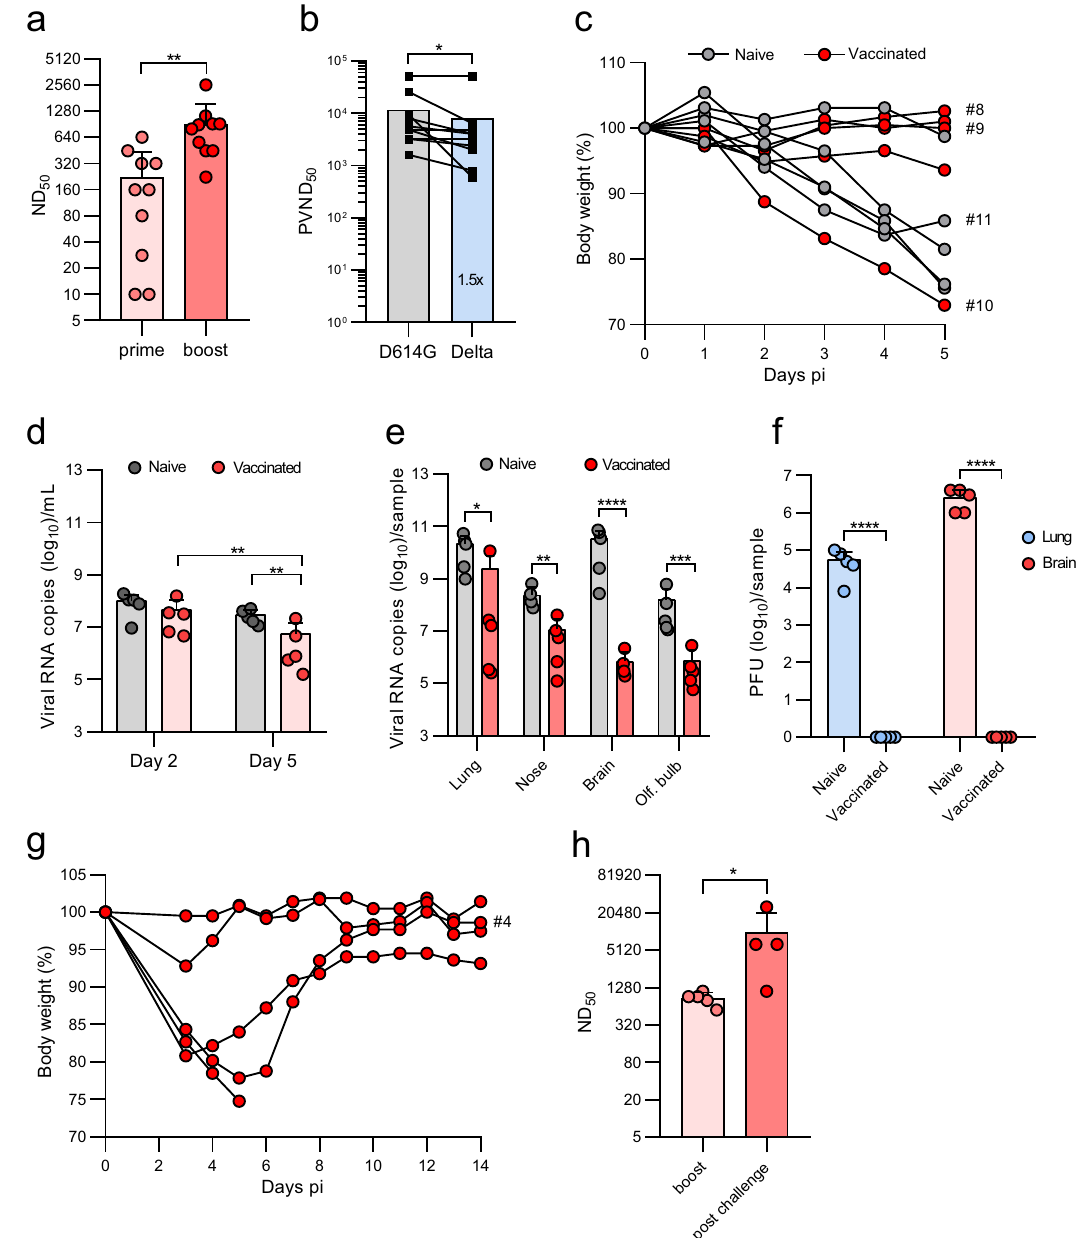
Fig. 7 The VSV* Δ G-S Δ 21 vaccine partially protects K18-hACE2 mice from SARS-CoV-2 Delta infection. K18-hACE2 mice ( n = 10) were immunized (i.m.) twice with 10 6 ffu of VSV* Δ G-S Δ 21. a Determination of VSV* Δ G-S Δ 21 -neutralizing antibodies in serum collected 3 weeks after the fi rst (prime) and 3 weeks after the second immunization (boost). b Determination of the pseudotype virus neutralization dose 50 (PVND 50 ) using the VSV* Δ G(FLuc) reporter virus pseudotyped with the S D614G or S Delta protein. c – h Four weeks after the second immunization, animals were infected with 8×10 4 pfu of SARS-CoV-2 Delta VOC via the nasal route. A group of naïve K18-hACE2 mice ( n = 5) served as control. c Relative body weight of mice in the course of infection up to day 5 pi. Some Individual curves were labeled with an ID number to identify the animals in the histological analysis (Supplementary Fig. 4A). d , e Quanti fi cation of SARS-CoV-2 RNA copies by RT-qPCR in oropharyngeal swab samples collected at days 2 and 5 pi ( d ), and in the indicated organs prepared at day 5 and 14 pi ( e ). f Determination of infectious SARS-CoV-2 Delta titers in homogenates of lung and brain at day 5 pi. g Relative body weight of vaccinated mice in the course of infection with SARS-CoV-2 Delta up to day 14 pi. h Determination of neutralizing serum antibody titers (ND50) 18 days after the boost and 14 days post challenge infection. Mean values and SD are shown. Statistical signi fi cance was calculated by the unpaired Student ’ s t test ( a , e , f , h ), by the paired Student ’ s t test ( b ), and by the two-way ANOVA test ( d ) (* p < 0.05, ** p < 0.01; *** p < 0.005; **** p < antibodies in the airways and further limit virus replication and expression levels and strong stimulation of the immune system. lung pathology 4 . High titers of neutralizing antibodies after a We therefore anticipate that vaccinated humans would develop a protective immune response shortly after one intramuscular second immunization will also help to better protect from immunization. However, a second vaccination is still recom- replication of emerging VOCs as these variants are neutralized mended as it will further improve the availability of spike-speci fi c with signi fi cantly lower ef fi cacy.